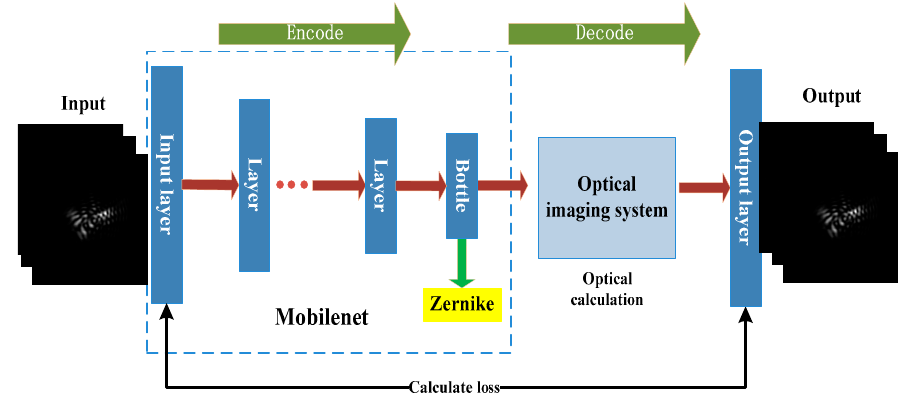
Figure 2. Structure diagram of the self-supervised learning neural network